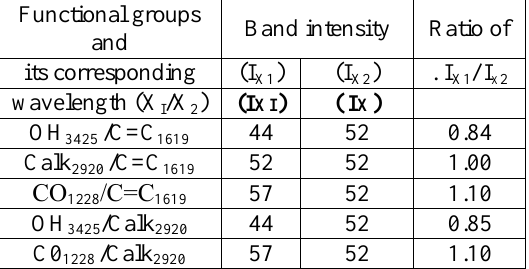
Table 2. Comparison of band intensities in FTIR spectra of the peloid-derived HA Functional groups